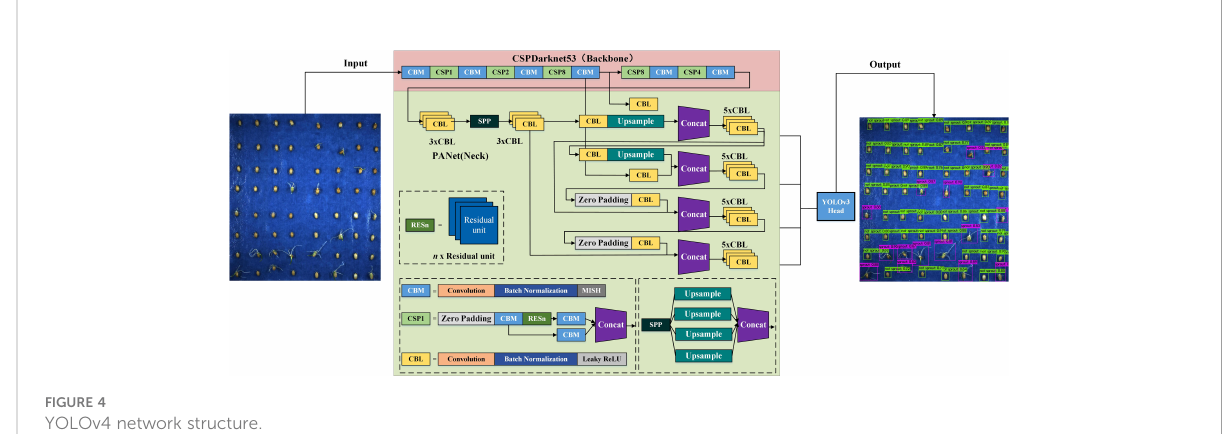
FIGURE 4 YOLOv4 network